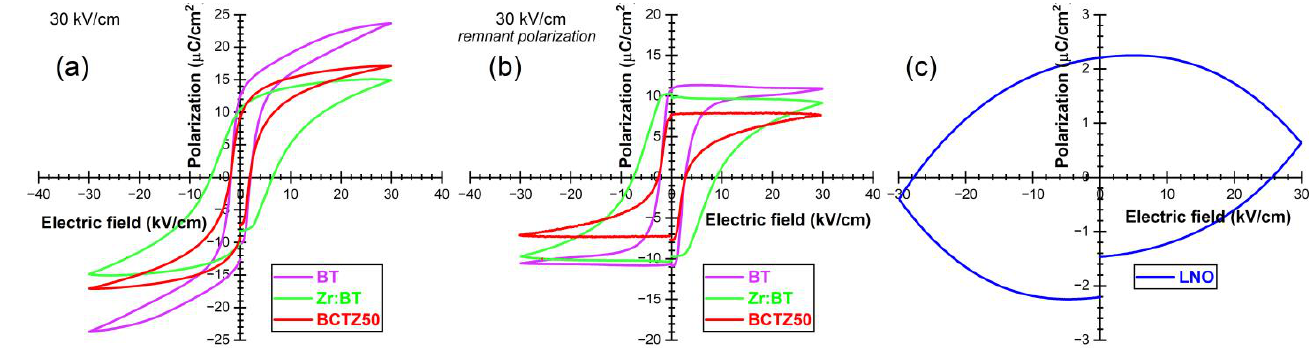
Figure 5. The ( a ) total and ( b ) remnant polarization vs. electric field of BT, Zr:BT and BCTZ50. ( c ) Total polarization vs. electric field in the case of LNO.